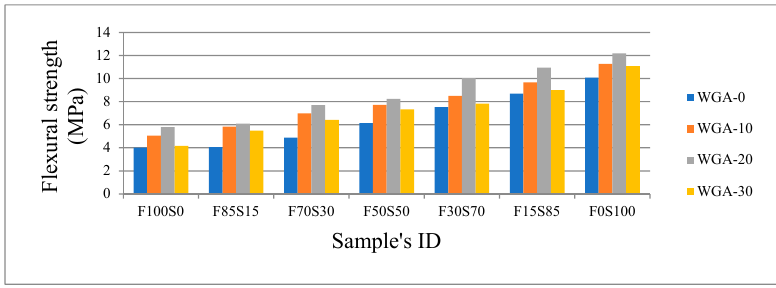
Figure 5. Flexural strength versus FA/GGBS and WGA solution.